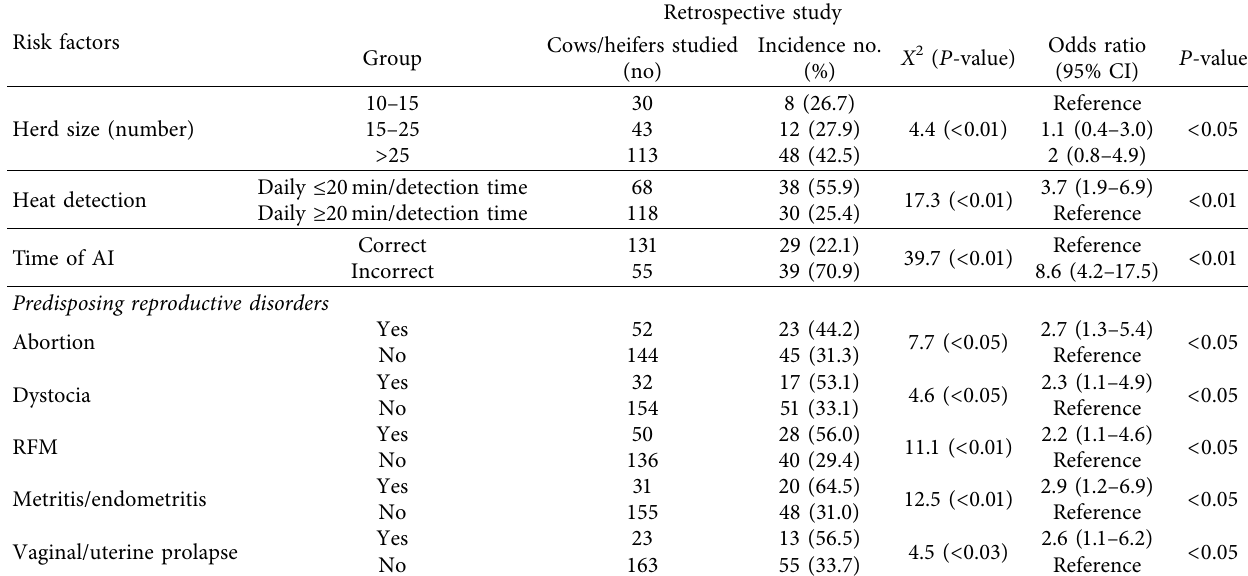
Table 5: Incidence of repeat breeding with risk factors (herd size, heat detection, time of insemination, and predisposing reproductive disorders) in crossbred dairy